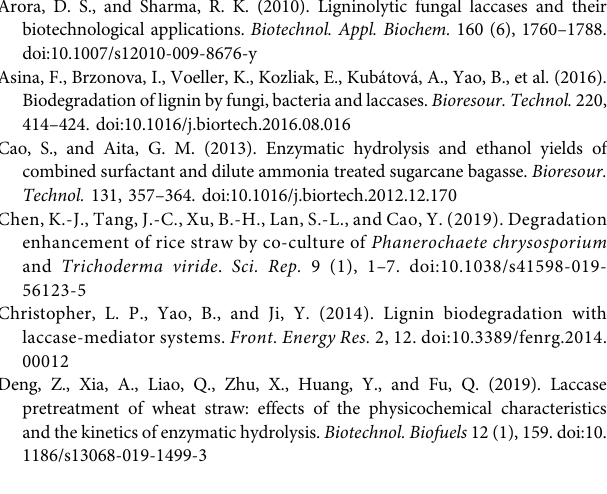
Frontiers in Energy Research |